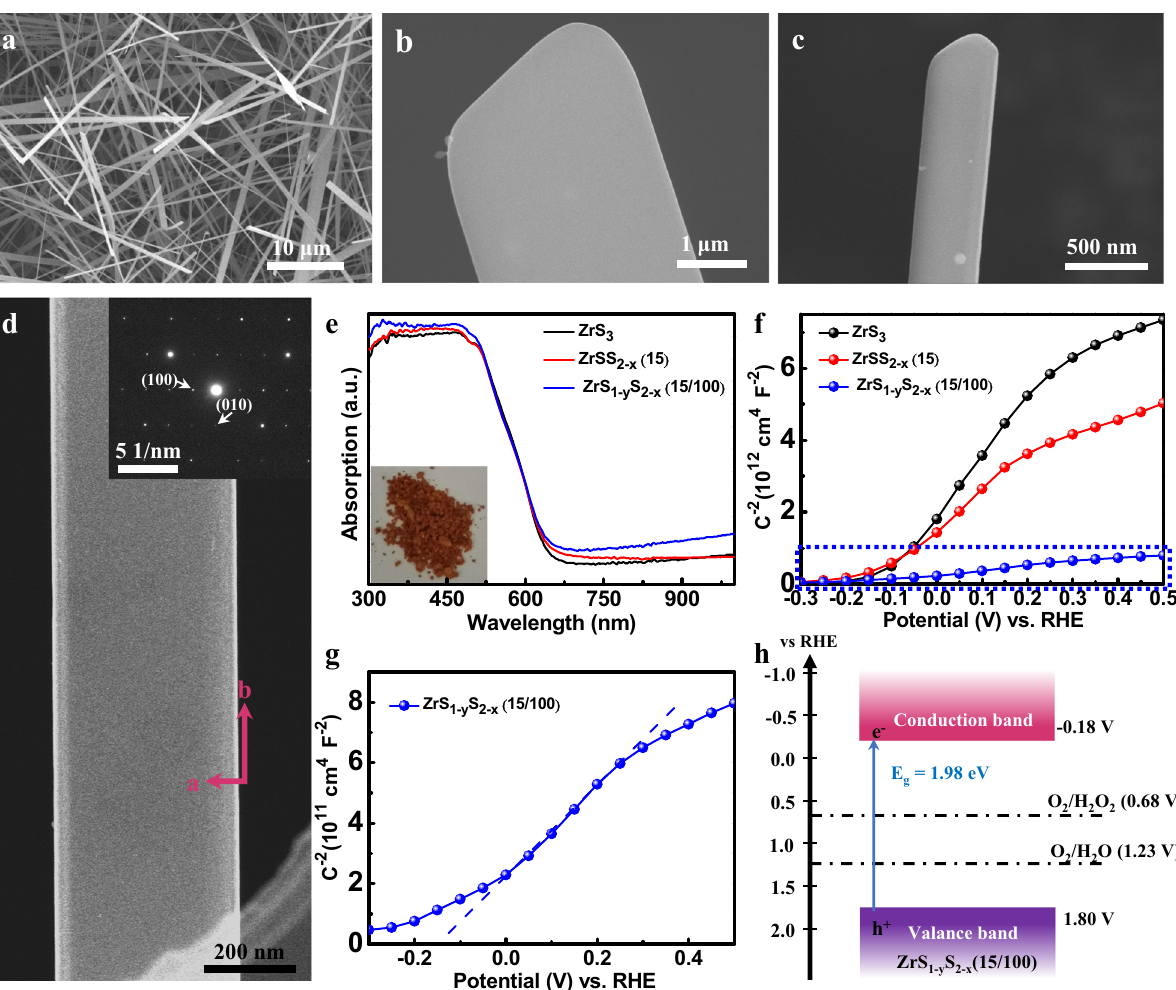
Fig. 2 Structural properties and band structures of defective ZrS 3 NBs. a Top-sectional, b , c high-magni fi cation SEM images of the ZrS 3 NBs. d TEM image and SAED pattern of single ZrS 3 NB. e Diffuse re fl ectance UV – vis spectra of the ZrS 3 , ZrSS 2-x (15) and ZrS 1-y S 2-x (15/100) NBs. Inset, the photograph of the ZrS 1-y S 2-x (15/100) NBs. f Mott – Schottky plots of ZrS 3 , ZrSS 2-x (15) and ZrS 1-y S 2-x (15/100) NBs and g Mott-Schottky plot of ZrS 1-y S 2-x (15/100) magni fi ed from f . h Schematic band structure diagram for ZrS 1-y S 2-x (15/100). To have a clear view of the single NB, the sample for this SEM measurement was prepared by evaporating the isopropanol dispersion of ZrS 3